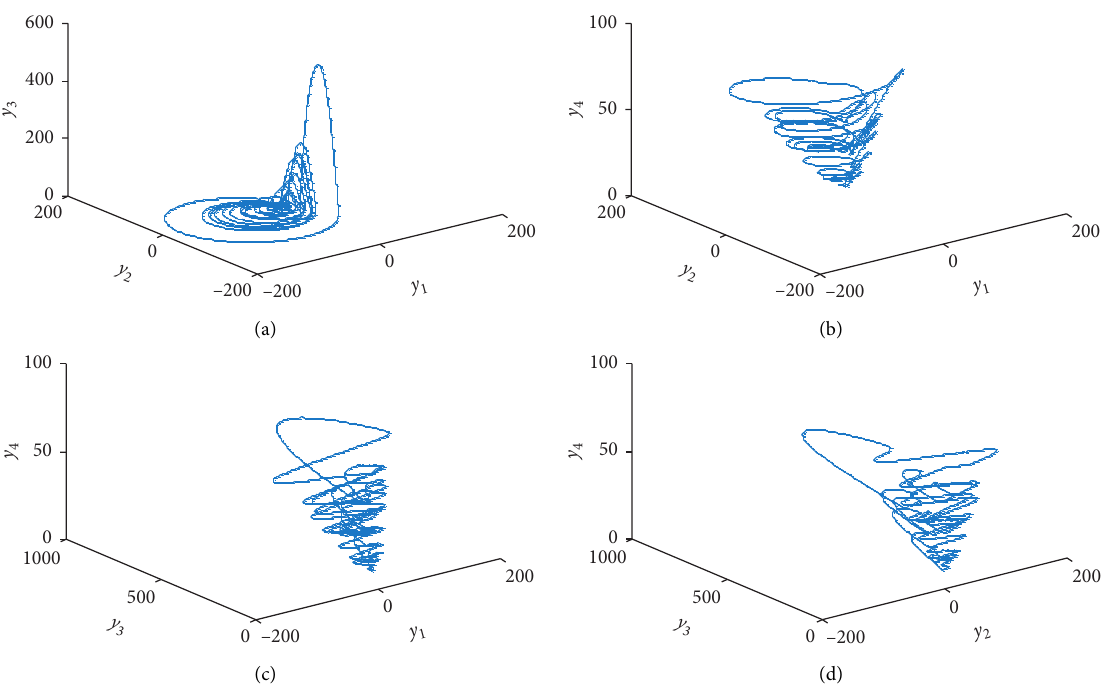
Figure 2: Typical dynamical behaviors of the hyperchaotic Rossler system: (a) projection in ( y space; (c) projection in ( y